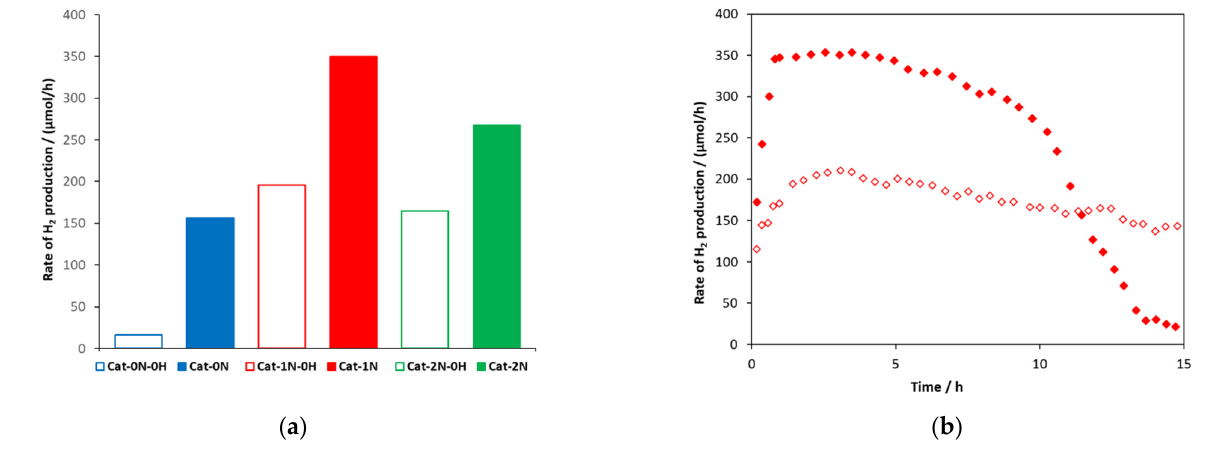
Figure 2. ( a ) Overall rate of H 2 production for Cat-xN-(0H) before and after HTT (x: 0, 1, and 2) between 200 and 400 min, ( b ) overall rate of H 2 production for Cat-1N before (-0H, empty marks) and after (filled marks) HTT as a function of time from a 0.13M Na 2 S/0.18 M Na 2 SO 3 solution.